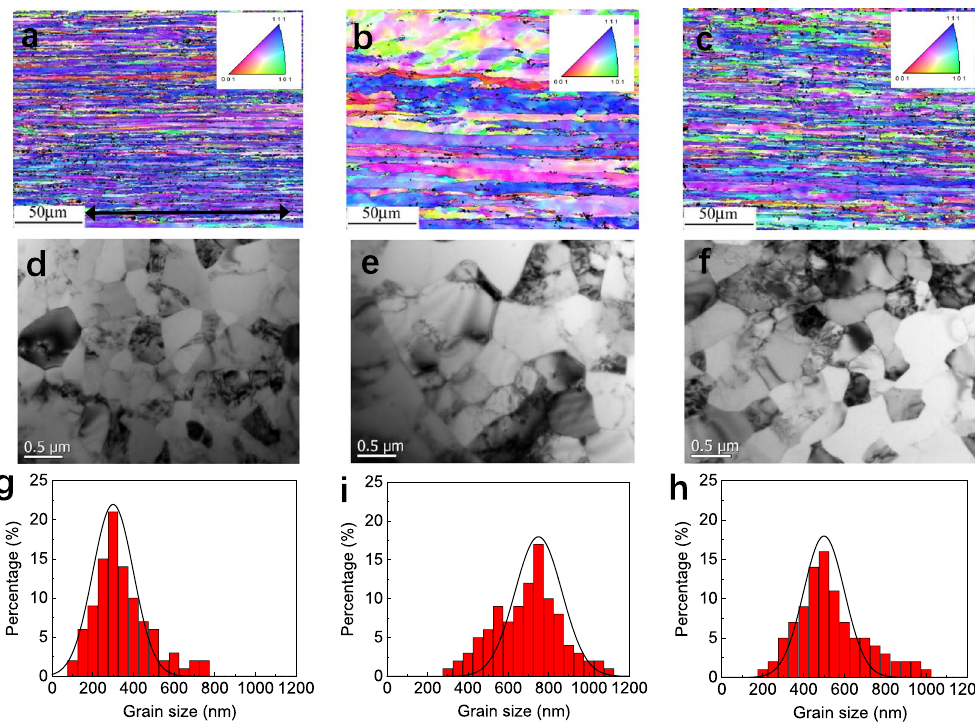
Figure 1. Representative EBSD images, TEM images, and statistical results on the grain size distribution. ( a – c ) Are longitudinal EBSD images, ( d – f ) are cross-sectional TEM images, and ( g – i ) are statistical results on the grain size distribution of the I-type ( a , d , g ), II-type-265 ( b , e , h ), and III-type-265 ( c , f , i ) Al-Zr conductors, respectively. The arrow in (a) indicates the cold drawing